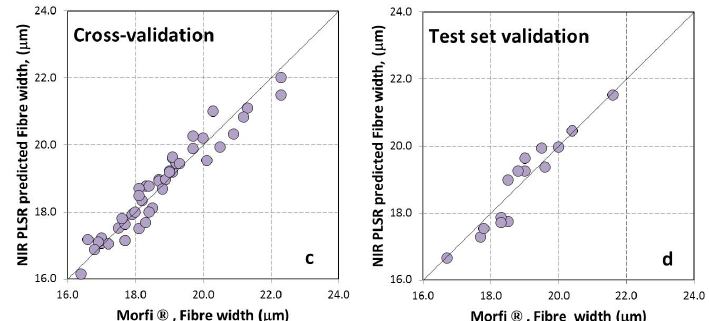
Figure 1. NIR ‐ PLS ‐ R predicted versus laboratory determined fiber length and fiber width for